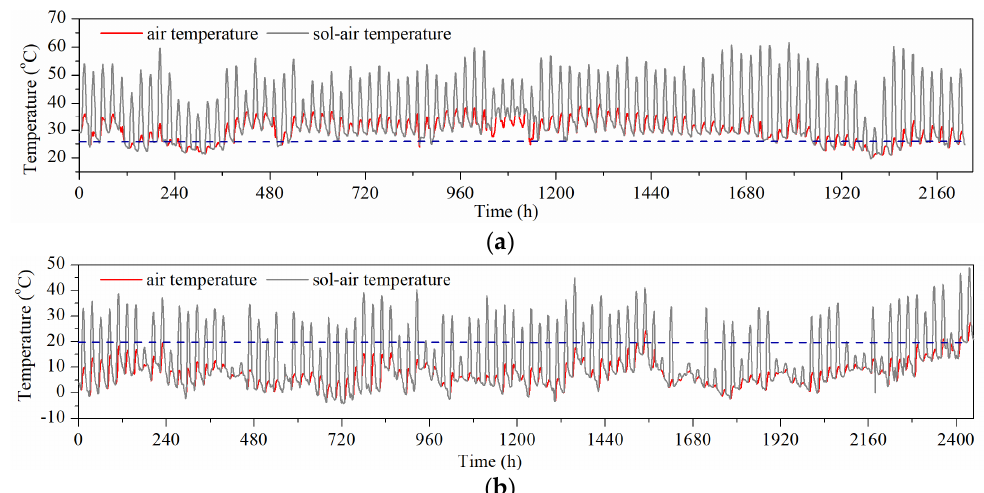
Figure 2. Climate data of Shanghai ( a ) in summer and ( b ) in winter.